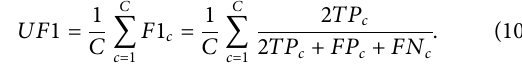
TABLE 8 | LOSO-CV performance of the proposed method, baselines, and the recent methods (* references from the MEGC 2019 challenge). Bold: score > 0.90. Models